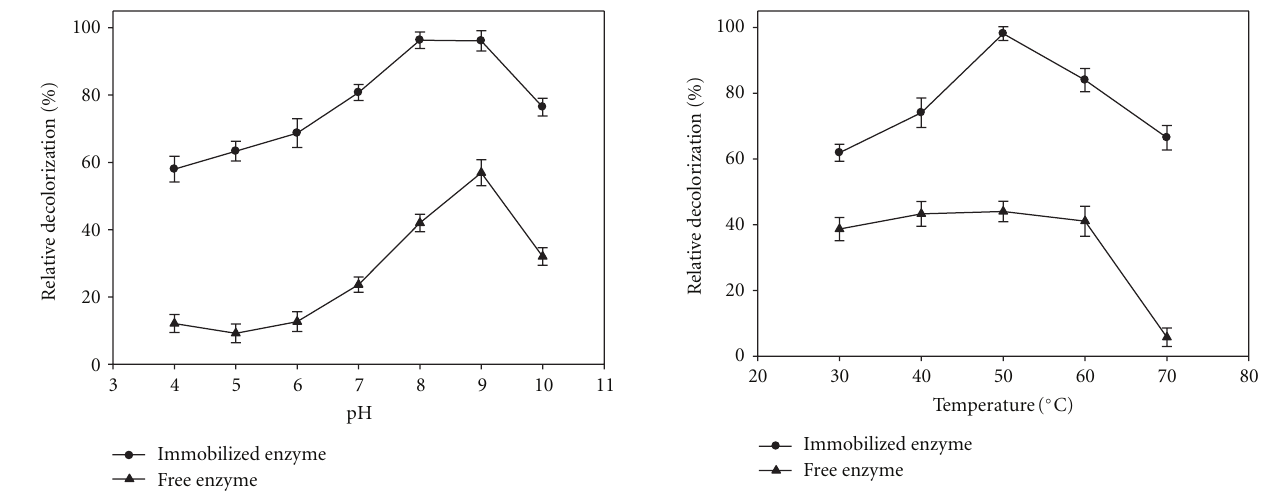
Figure 2: E ff ect of pH on relative decolorization activity of free laccase ( (cid:2) ) and immobilized laccase ( • ). Data were mean values ± SD.